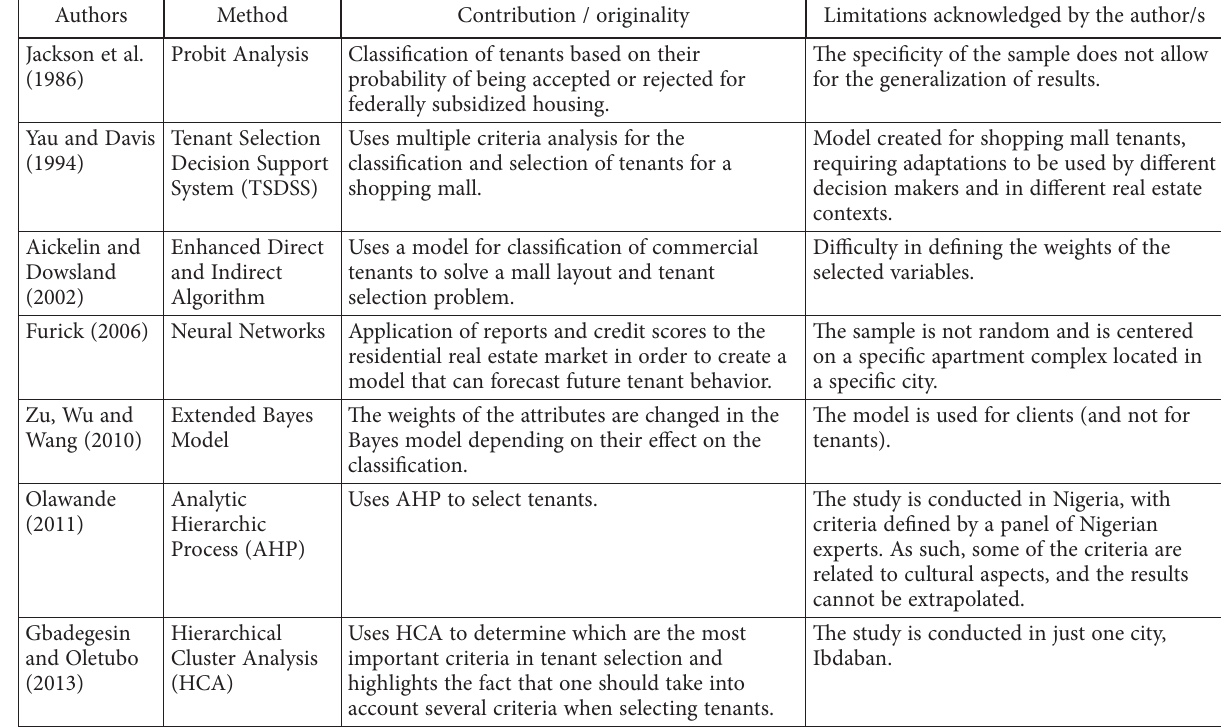
Table 1. Classification and selection methods: contributions and